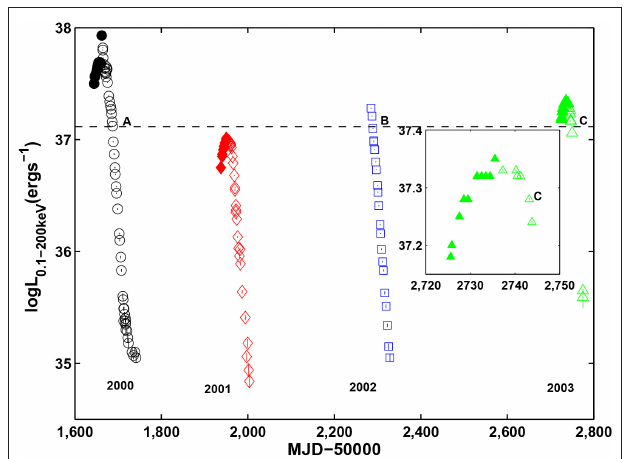
FIGURE 1 | The RXTE/PCA light curve of XTE J1550-564 on MJD = 51600–51280, where the filled and open points represent the observations in the rise phase and in the decay phase, respectively. Black circles represent the normal outburst in 2000. Red diamonds represent the mini-outburst in 2001. Blue squares represent the mini-outburst in 2002. Green triangles represent the mini-outburst in 2003.